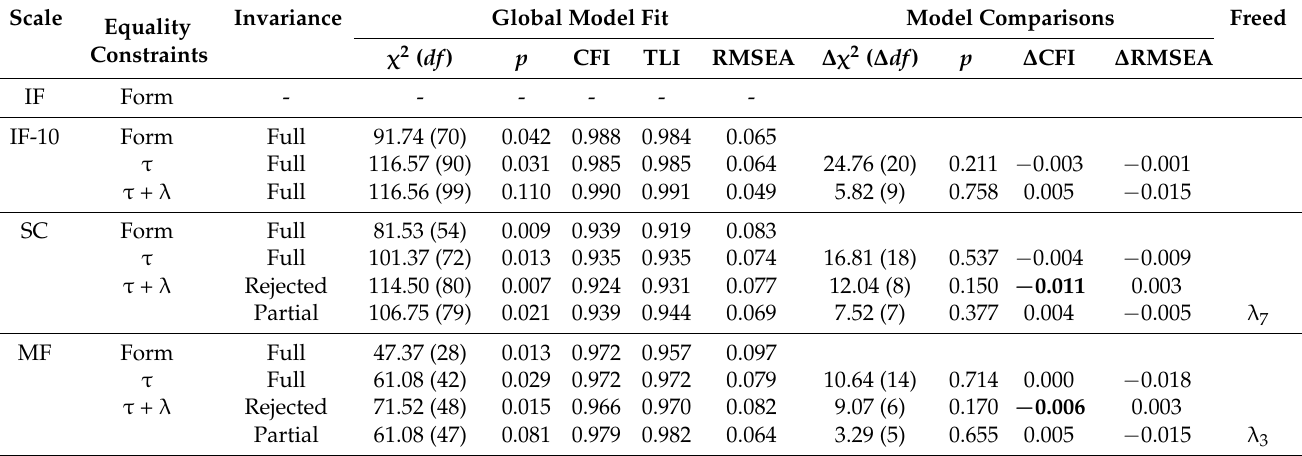
Table 3. Measurement invariance of Dutch Multifactor Fatigue Scale across rehabilitation